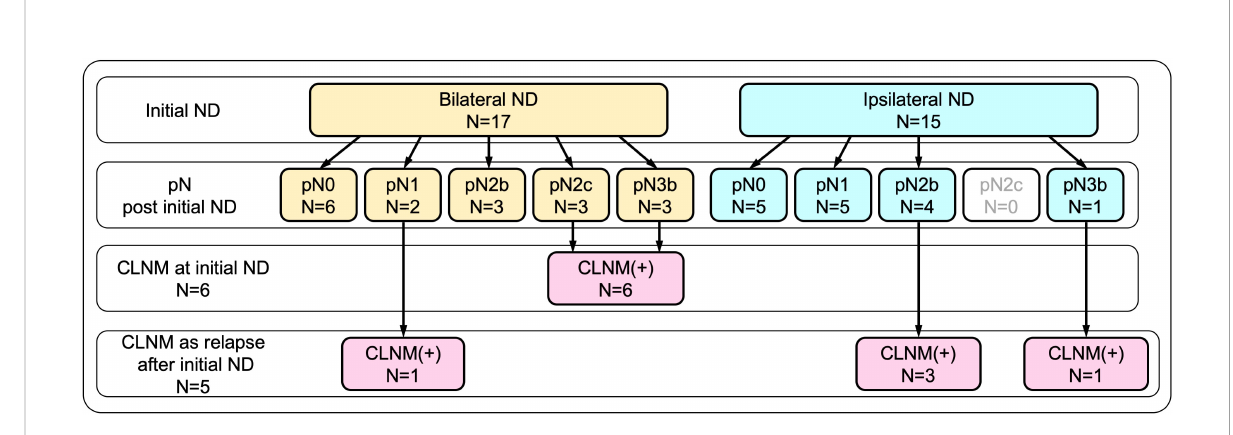
FIGURE 1 Breakdown of contralateral neck metastasis (CLNM) according to initial neck dissection. CLNM was eventually con fi rmed in 11 patients (34.4%) by the time of the last follow-up. Of these, six patients were con fi rmed by bilateral neck dissection performed as part of the initial surgery, while the remaining fi ve patients who developed CLNM as contralateral nodal relapse were con fi rmed by salvage contralateral neck dissection.